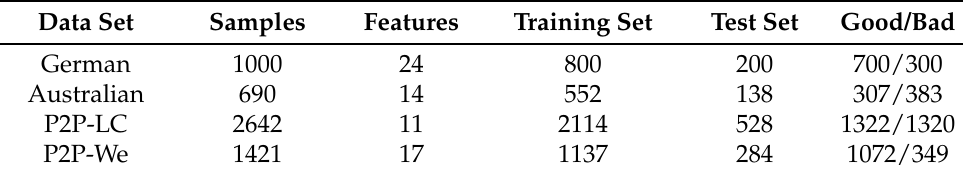
Table 5. Description of the experimental data